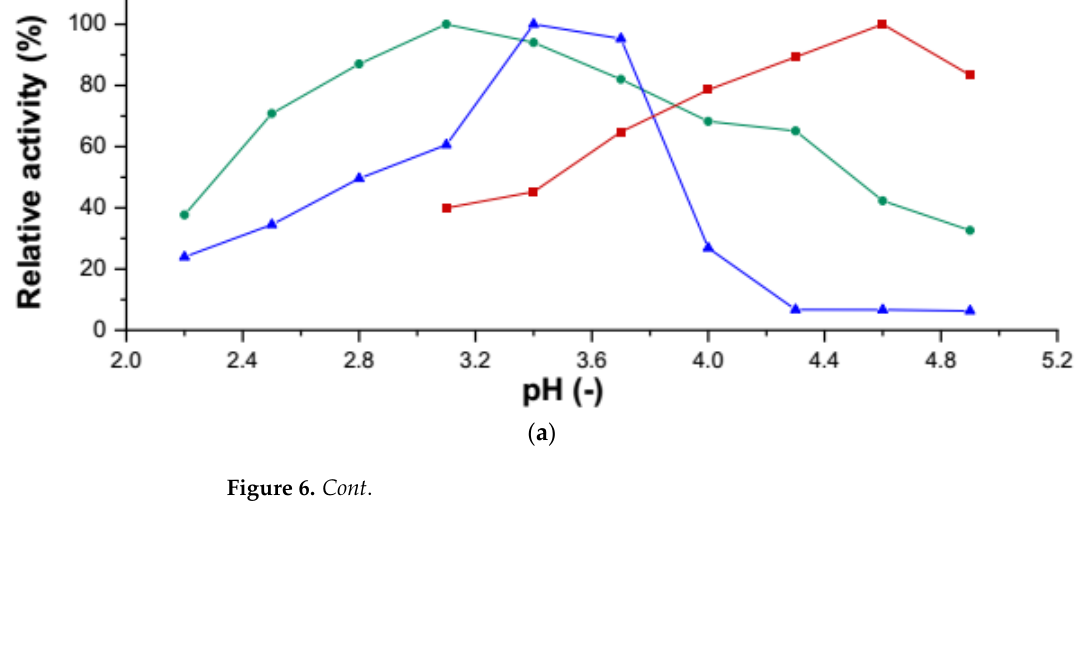
Figure 6. ( a ) Determination of the pH-optimum of r Cab UPO 1 ( ▲ ), r Cab UPO 2 ( ∎ ), and r Ani UPO (●) using ABTS as a substrate. An activity of 100% corresponds to the highest activity measured for each individual enzyme. ( b ) Determination of the pH-optimum of r Cab UPO 1 ( ▲ ), r Cab UPO 2 ( ∎ ), and r Ani UPO (●) using NBD as a substrate. An activity of 100% corresponds to the highest activity measured for each individual enzyme.